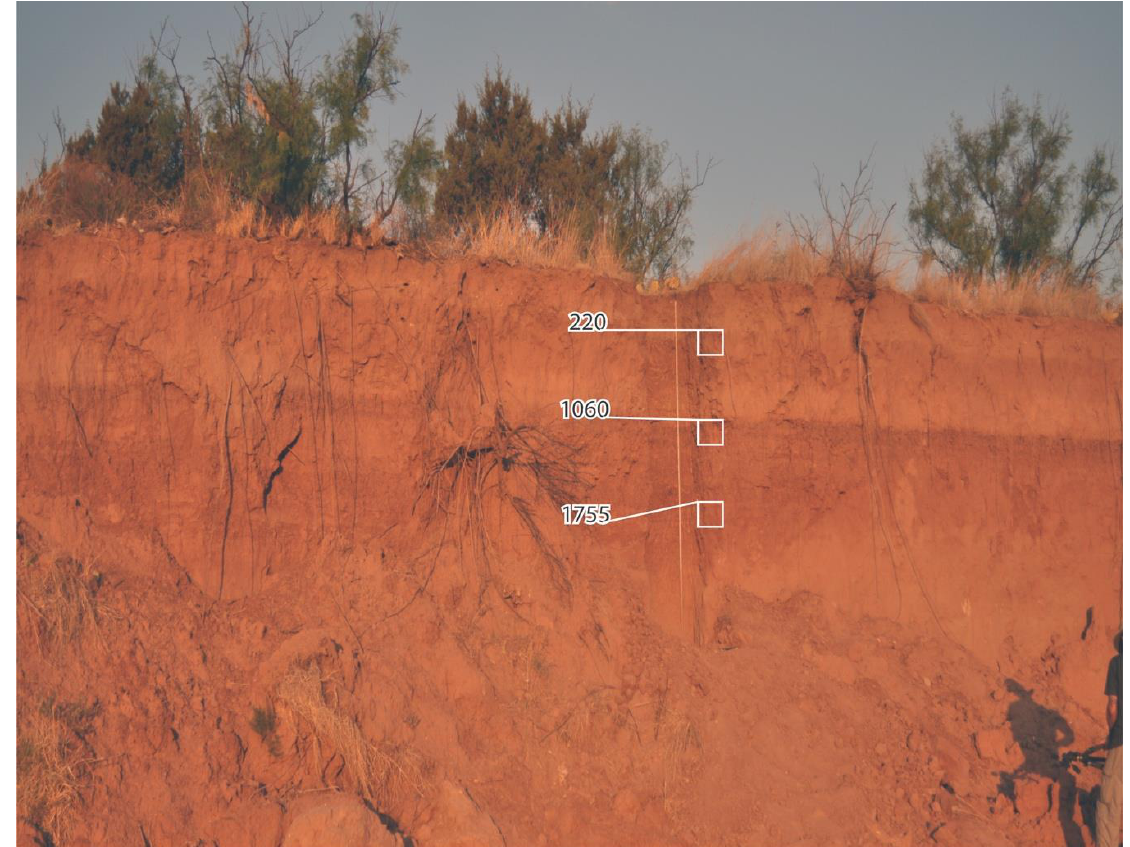
Figure 5. The late-Holocene South Fork pedocomplex (Macy Locality 263) and accepted radiocarbon ages of the South Fork River within the eastern escarpment breaks of the Southern High Plains, Texas; buried soils are identified with associated uncalibrated radiocarbon dates.